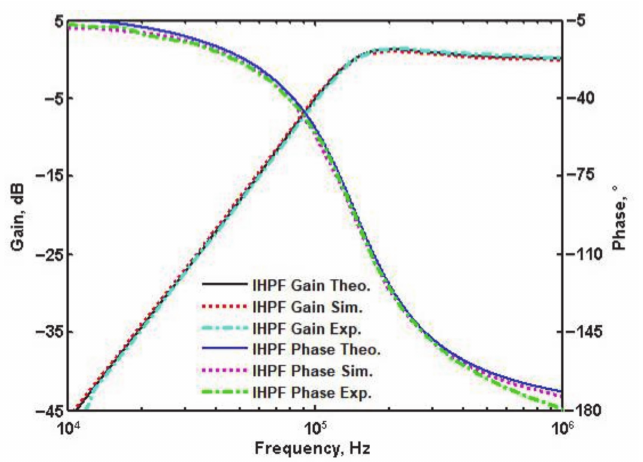
Figure 12. Comparison of IHPF experimental response, simulated response, and theoretical response in Part II.